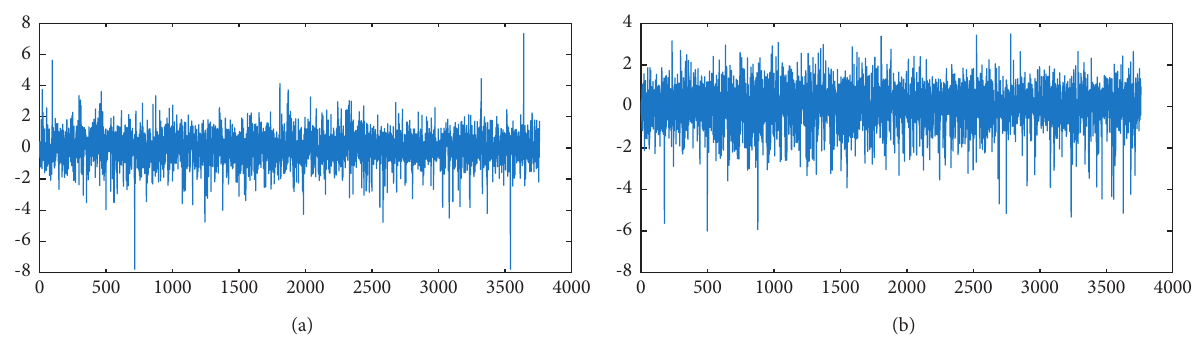
Figure 3: Standardized residual series for the SSEC index and S&P 500 index returns. (a) z